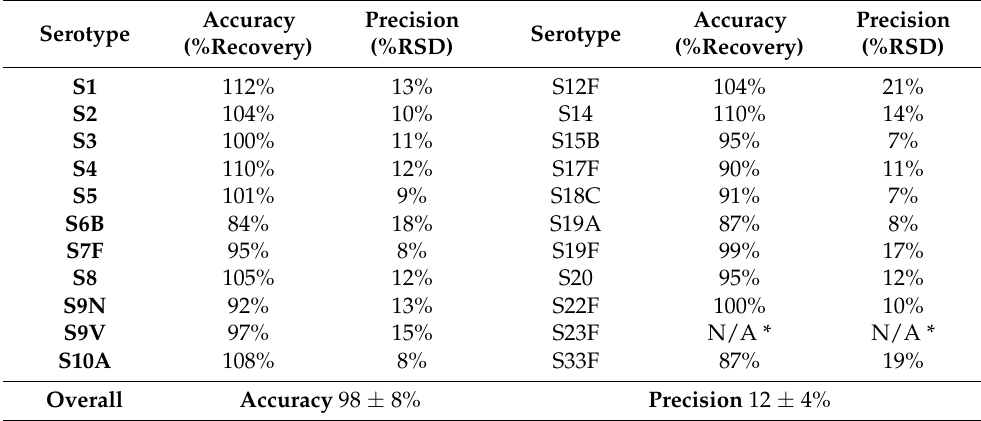
Table 4. Accuracy and precision for PNEUMOVAX ® 23 using 23-Mix Primary Detection Label. Expected concentration of each serotype is 0.2 µ